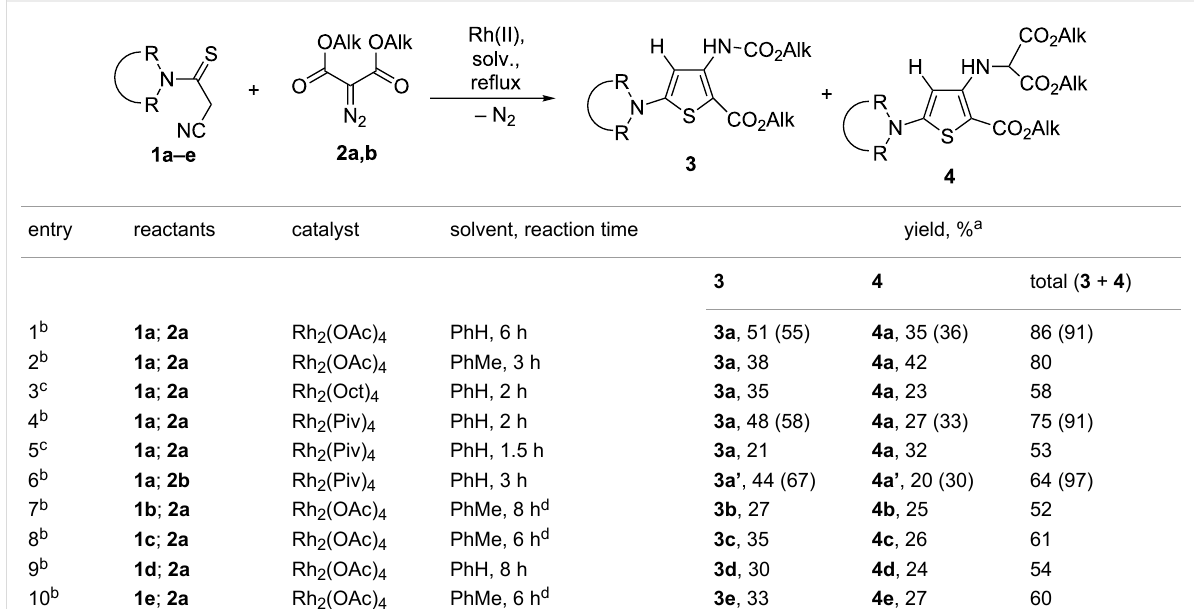
Table 1: Rh(II)-Catalyzed reactions of diazomalonates 2a,b with α -cyanothioacetamides 1a – e